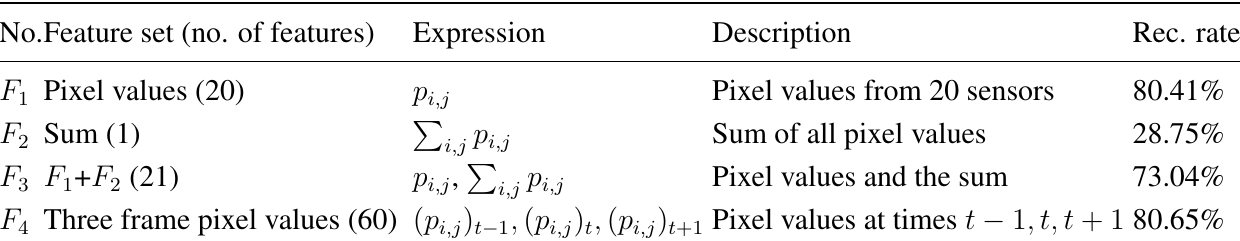
Table 2. Examined feature sets and recognition rates.